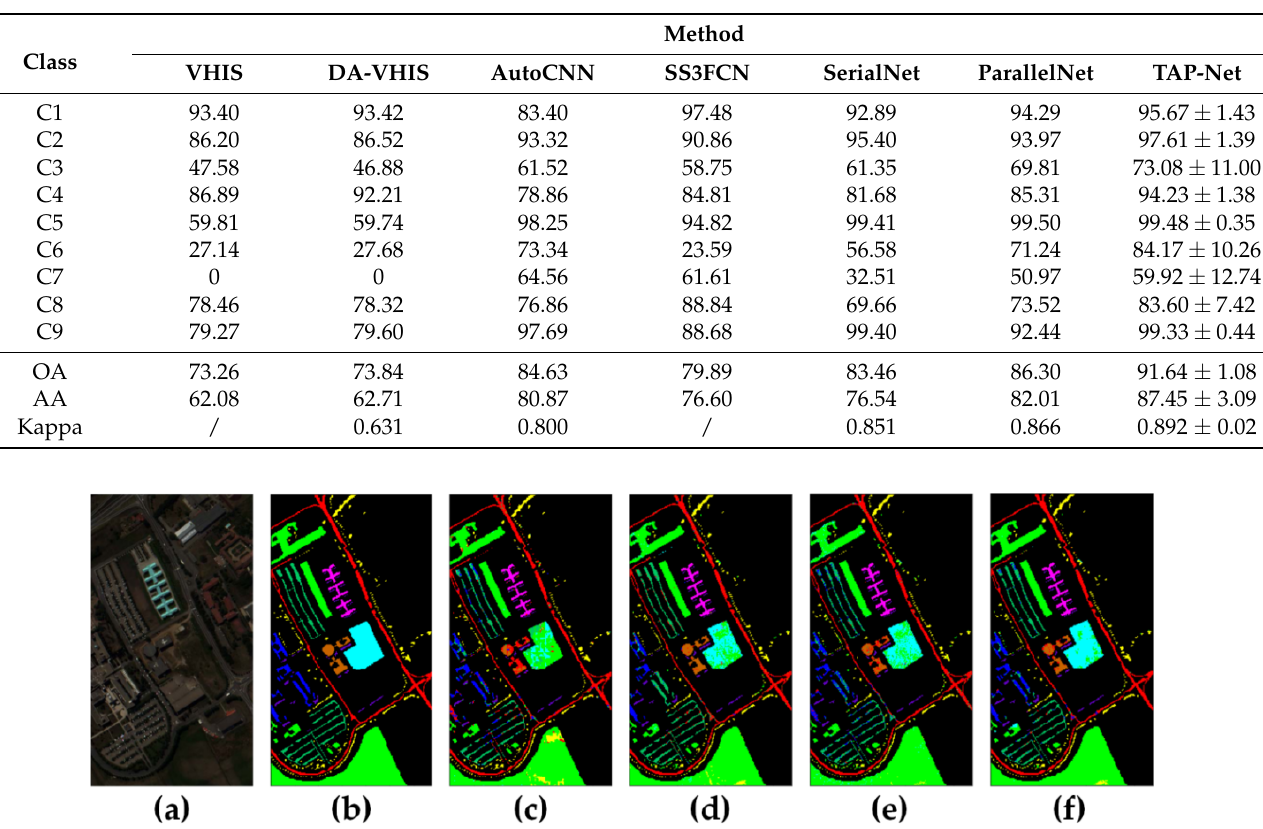
Figure 10. Classification maps of different models for Pavia University: ( a ) false color image, ( b ) ground truth, ( c ) SS3FCN, ( d ) SerialNet, ( e ) ParallelNet, and ( f )